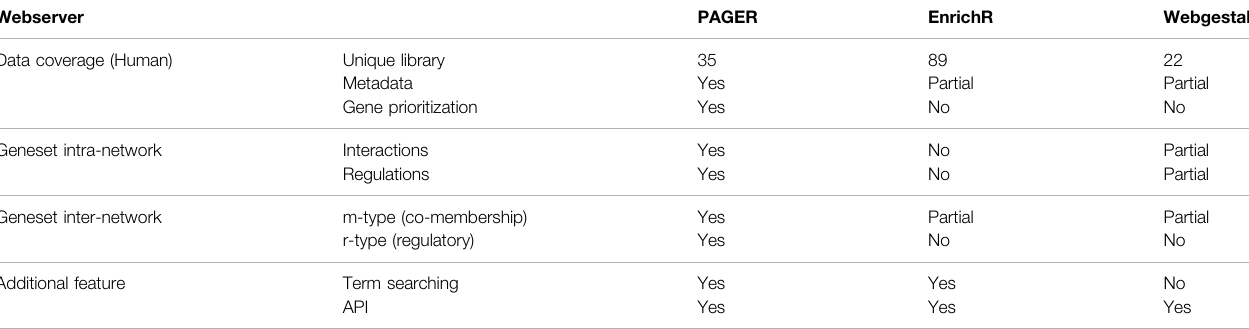
TABLE 1 | A comparison of data coverage and features among PAGER, EnrichR, and WebGestalt web servers.